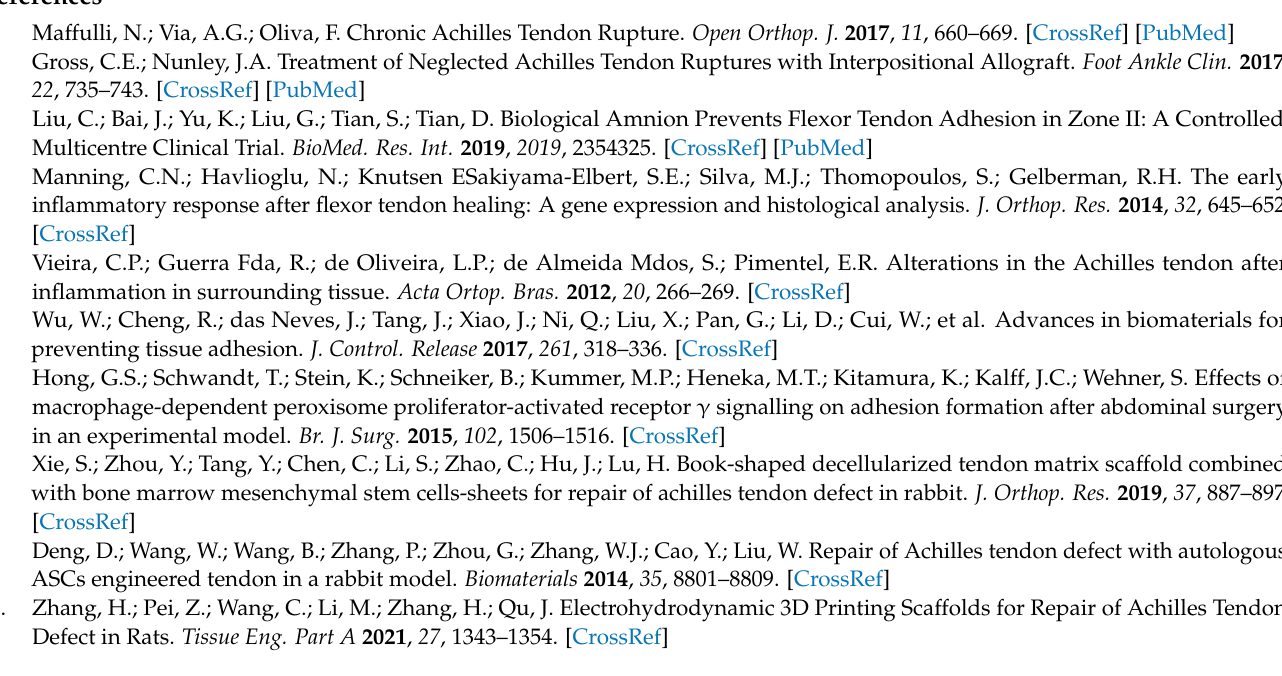
Figure S1: Masson tricolor staining of the coronal sections of the regenerated defects at 1, 2 and 3 months. Newly formed collagen fibers were visualized as blue and newly formed myofibrils were visualized as red. From loose and disordered collagen fibers to dense, orderly rows of collagen fibers, showing a time dependency, n =